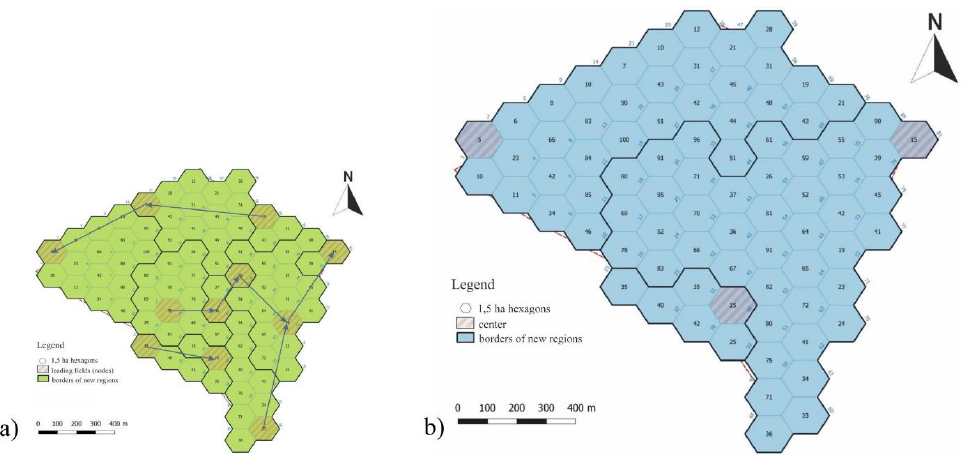
Figure 12. The second stage of aggregation of the landscape aesthetic value according to the minimum value decrease path; ( a ) the combination of values according to the principle of minimum value decrease; ( b ) new regions.